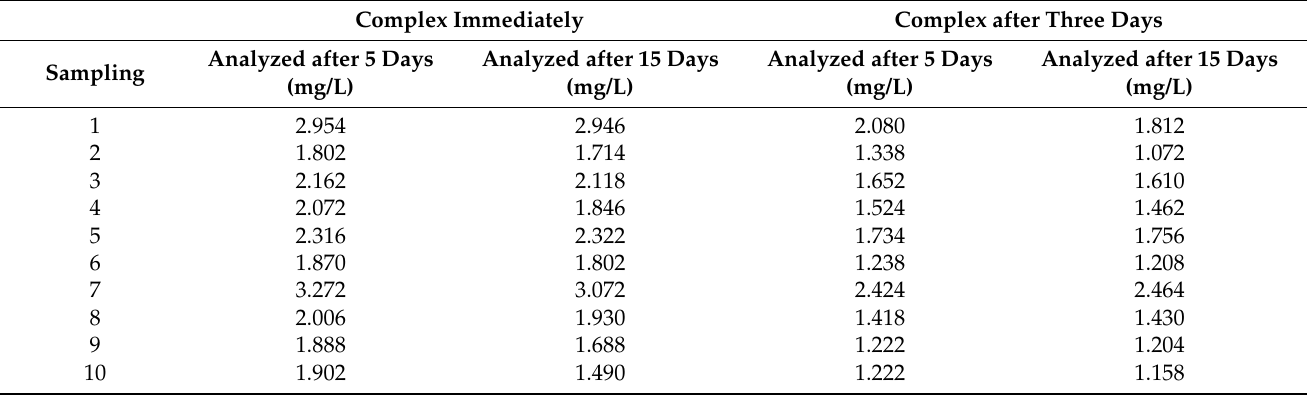
Table 14. Results of repeated analyzes on samples collected by Lab. RSE during Second Campaign. Complex Immediately